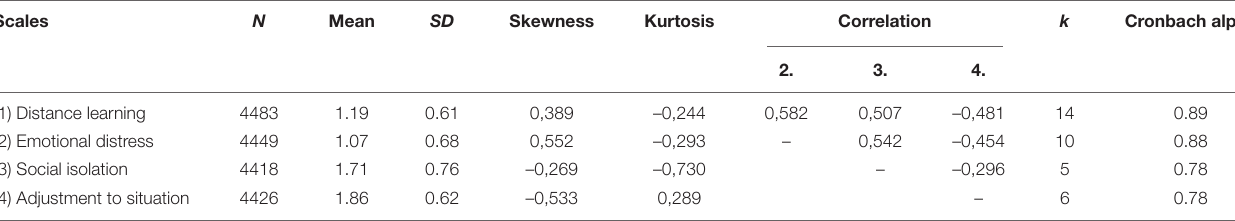
TABLE 2 | Main descriptive statistics and intercorrelations of the composite scale scores. Scales